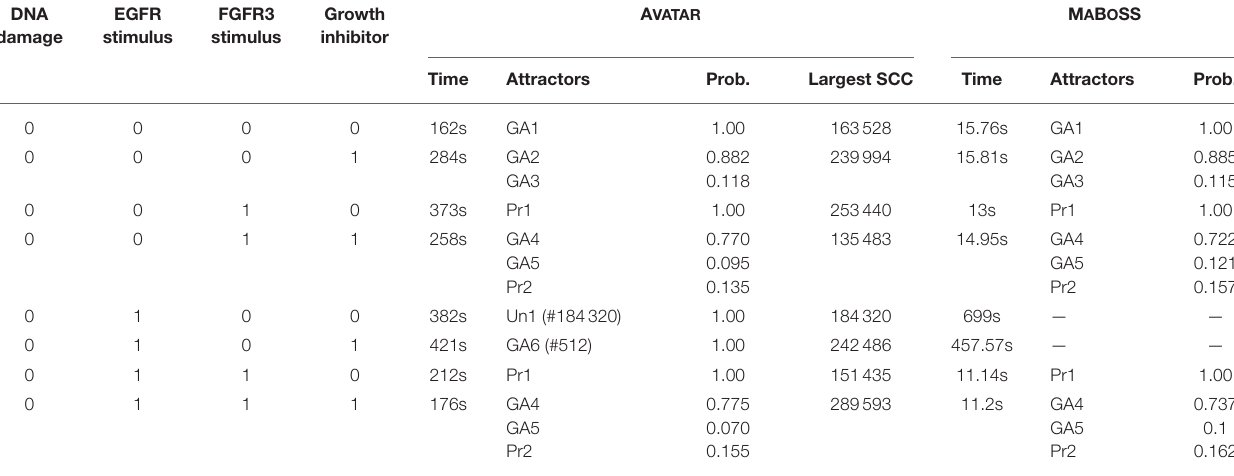
TABLE 3 | Attractor analysis of the bladder tumourigenesis model performed with A VATAR and M A B O SS. DNA